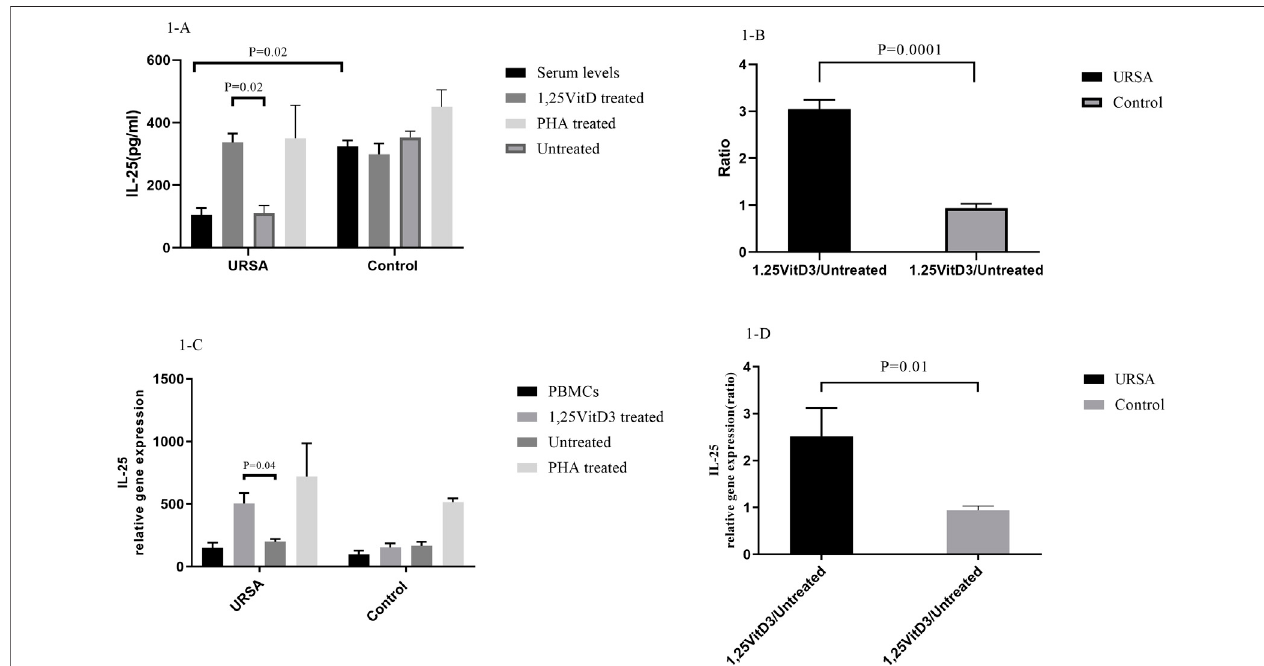
FIGURE 1 | IL-25 expression at mRNA and protein levels. (A) . IL-25 serum levels were signi fi cantly lower in women with URSA than in the control group. IL-25 concentrations in the cell culture supernatants were signi fi cantly lower in women with URSA relative to the control group. (B) .1,25VitD3/Untreated relative gene expression for IL-25 levels decreased in women with URSA relative to the control group. (C) .1,25VitD3 treatment signi fi cantly improved IL-25 expression at mRNA level compared to the untreated PBMCs in URSA patients. (D). 1,25VitD3 treatment signi fi cantly improved IL-25 expression at protein level compared to the untreated PBMCs in URSA patients IL-25 relative gene expression (1,25VitD3/untreated) increased in the case group in comparison to the control group (2.52 ± 0.60 versus. 0.94 ± 0.09; p (cid:2) 0.01; Figure 1D ).